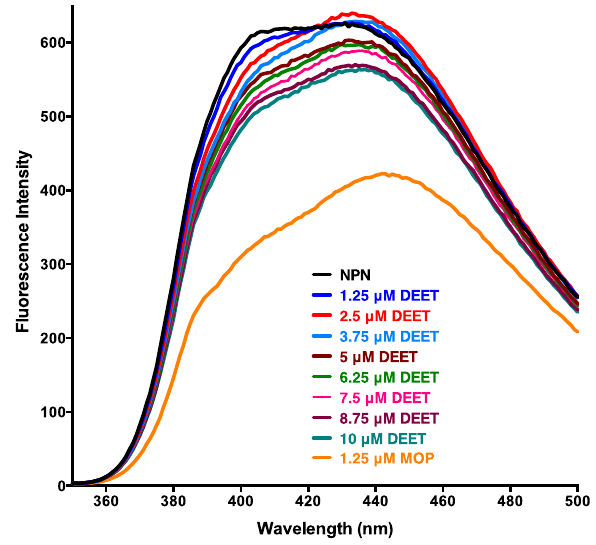
Figure 2. NPN fluorescence emission spectra. NPN bound to AaegOBP1 was excited at 337 nm and its emission spectra